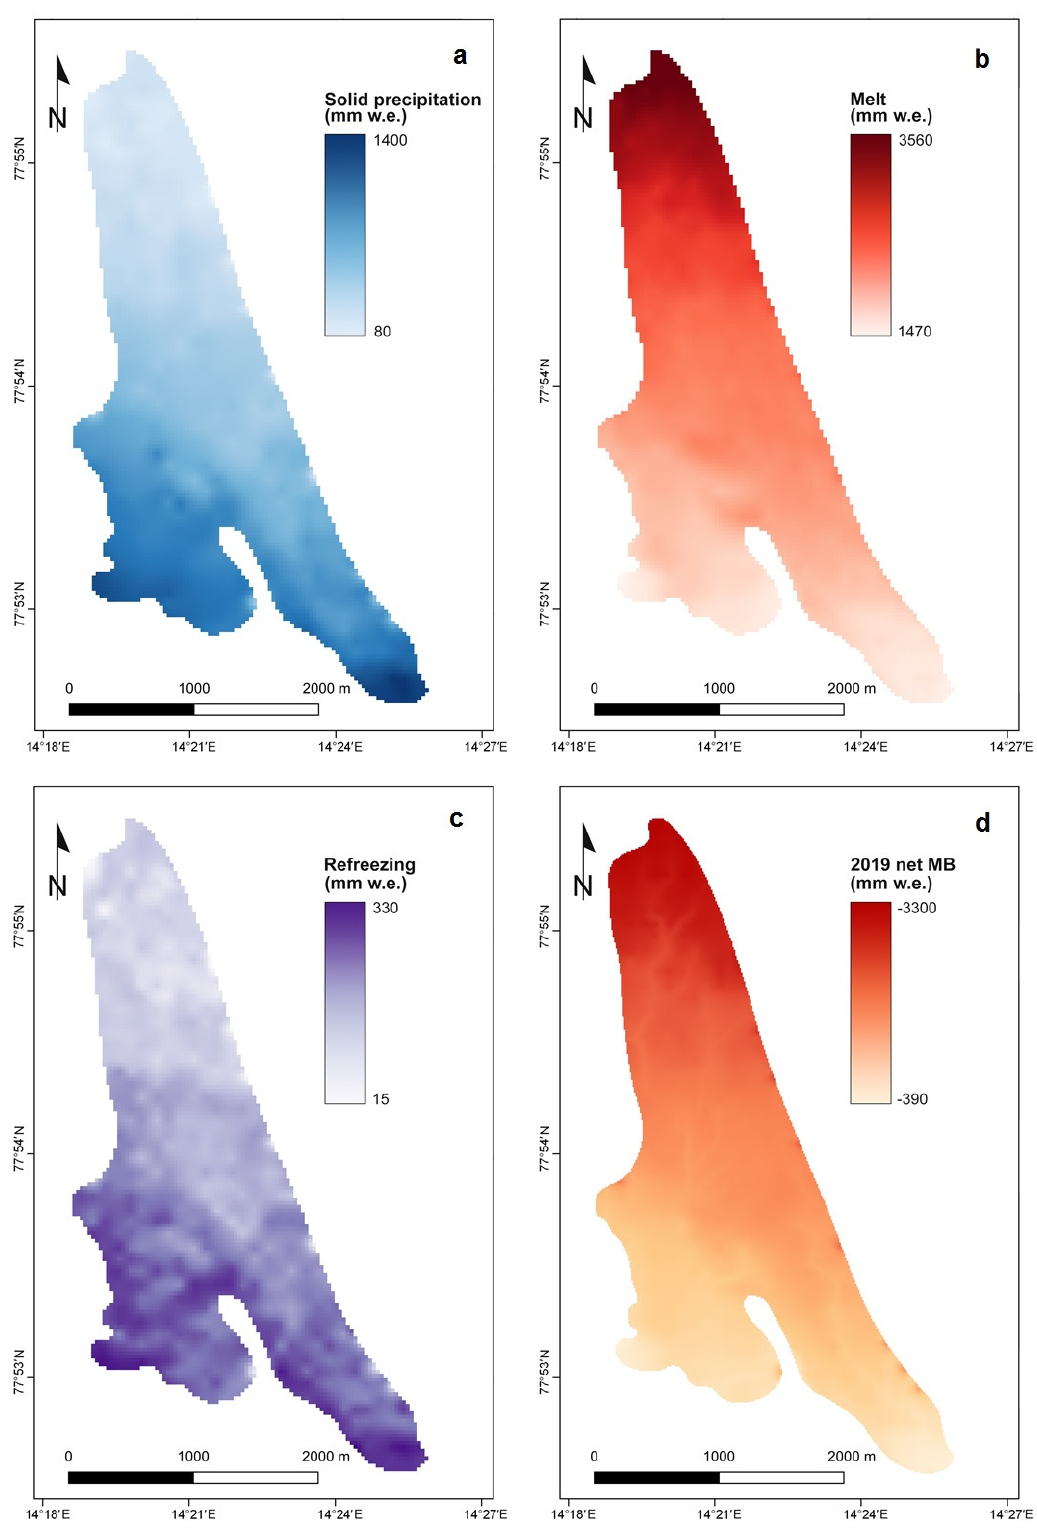
Figure 10. Spatially distributed mass balance components: ( a ) solid precipitation; ( b ) melt; ( c ) refreezing and ( d ) net mass balance averaged for 2019 balance year. Table 5. The mass balance, solid precipitation amount, melt and refreezing of Austre Grønfjord- breen modelled for 4 balance years.